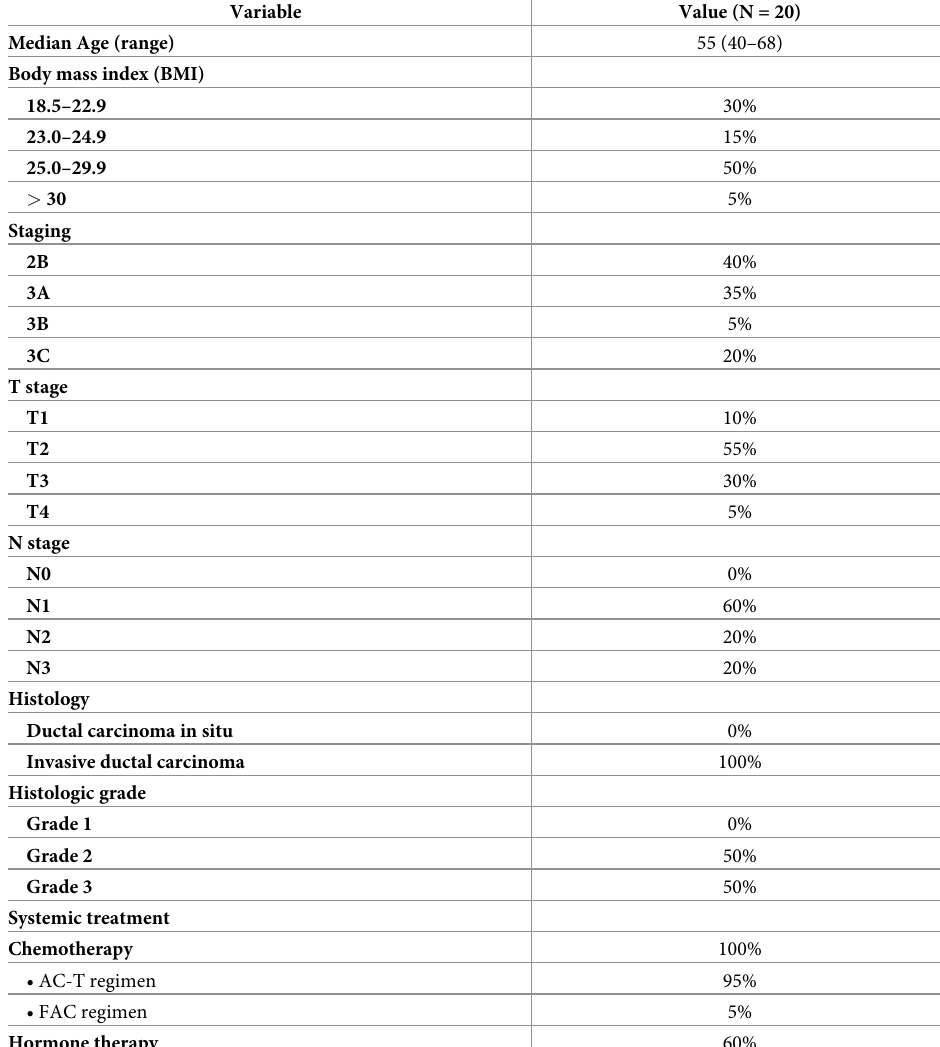
Table 1. Baseline